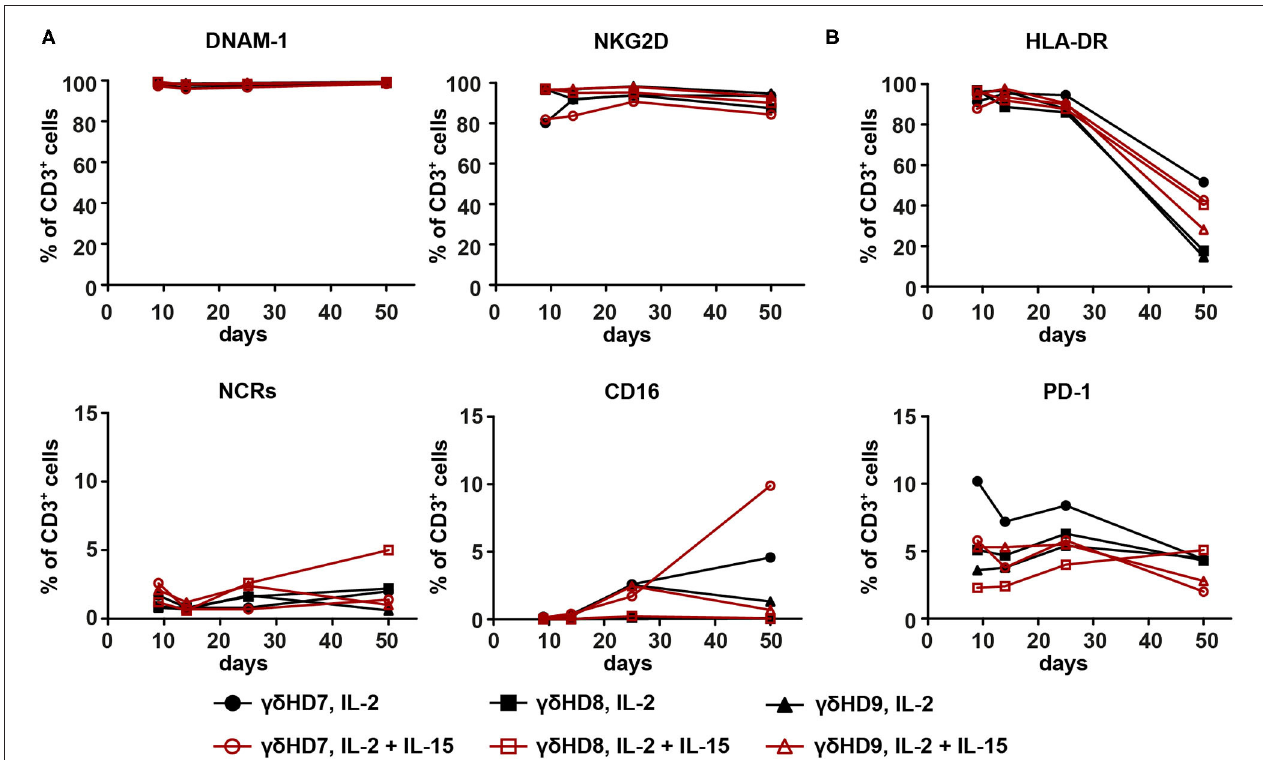
FIGURE 3 | Phenotype analysis of NK cell and activation markers of expanded V γ 9V δ 2T cell cultures did not reveal differences between IL-2-expanded and IL-2/IL-15-expanded cultures. The three purest V γ 9V δ 2T cell cultures from the 50-day expansions were analyzed by flow cytometry for (A) NK cell markers DNAM-1, NKG2D, NCRs (NKp30, NKp44, NKp46), and CD16, as well as (B) activation markers HLA-DR and PD-1. CD3 + cells were gated from single, live lymphocytes. Due to the high purity of cultures ( > 95% V γ 9 + of CD3 + cells), no γδ T cell marker was included. HLA-DR- and PD-1-positive cells were gated with the help of isotype controls; NCR-positive cells with a fluorescence-minus-one control ( n = 3 for both expansion conditions, representative data from two independent experiments; γδ